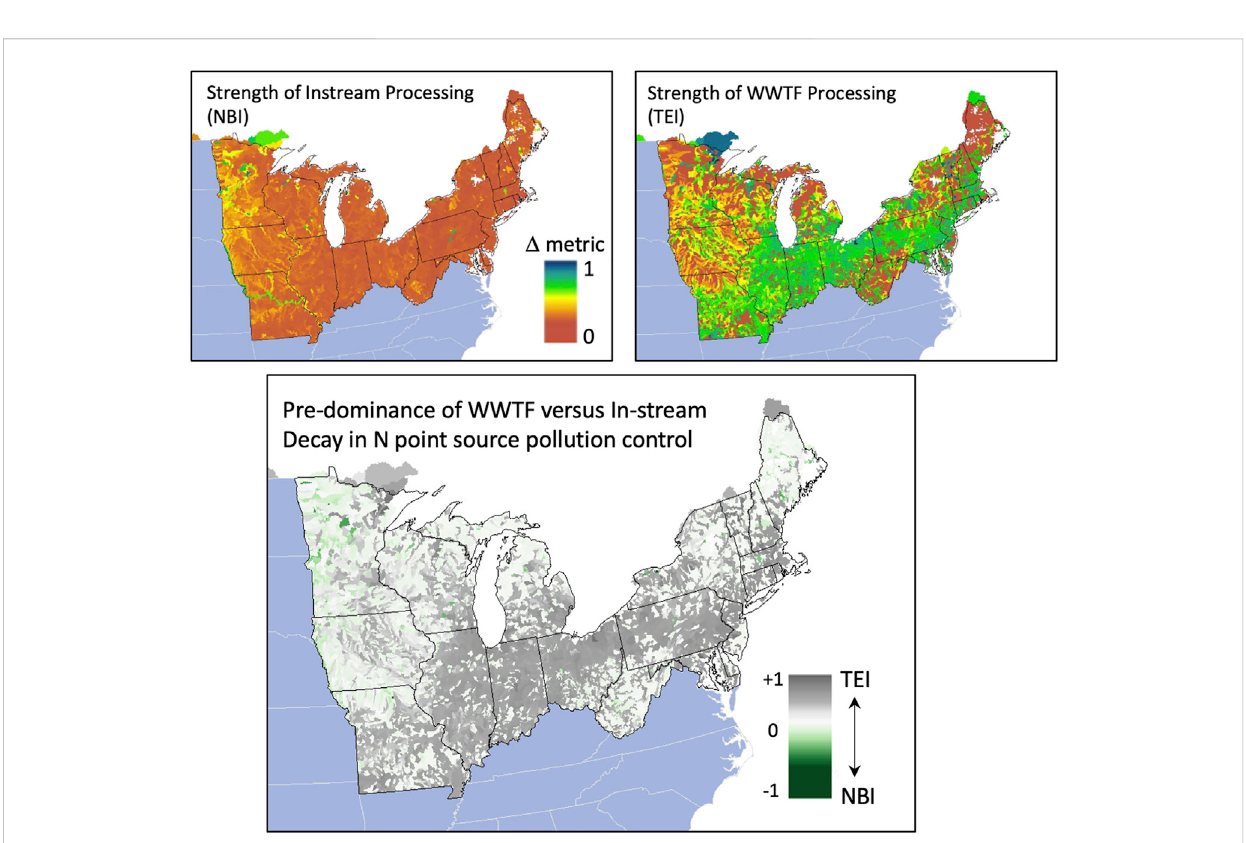
FIGURE 6 Analysis of engineered versus natural aquatic ecosystem infrastructure processing in controlling contemporary total nitrogen pollution from point sources in the NE and MW. The overall dominance of TEI (traditionally-engineered infrastructure) is indicated (with high Δ metric scores in the top right and lower panels), particularly in river reaches downstream of urban settings. However, additional within-basin patterns show many stream and river reaches with NBI (nature-based infrastructure) at parity with or exceeding TEI in